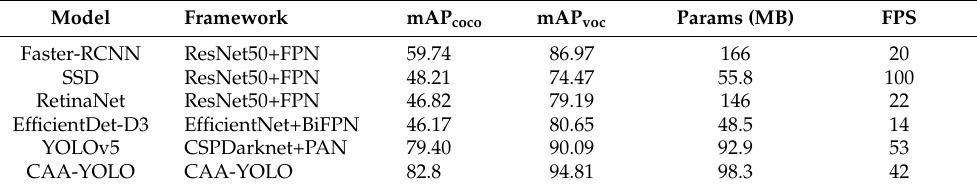
Table 9. Detection results of different algorithms on the infrared ship dataset.